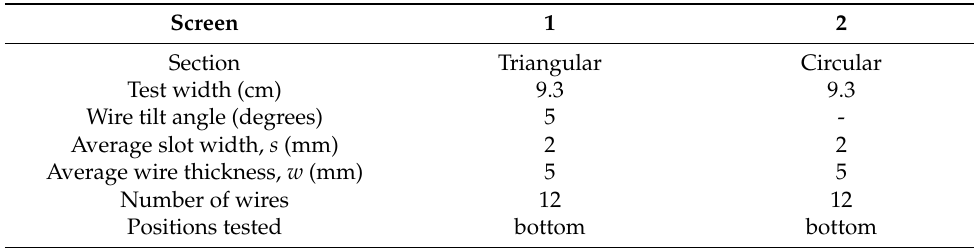
Table 1. Geometric Features of the Test Screens Used.